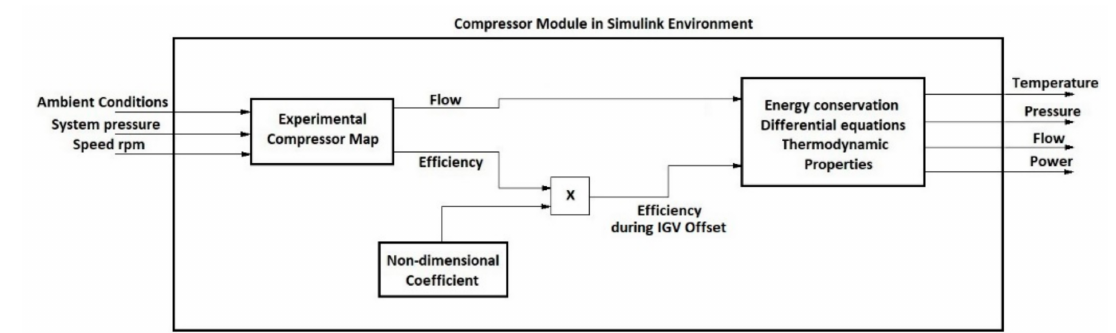
Figure 19. Measured inlet guide vane position during Incidents 1 and 4.